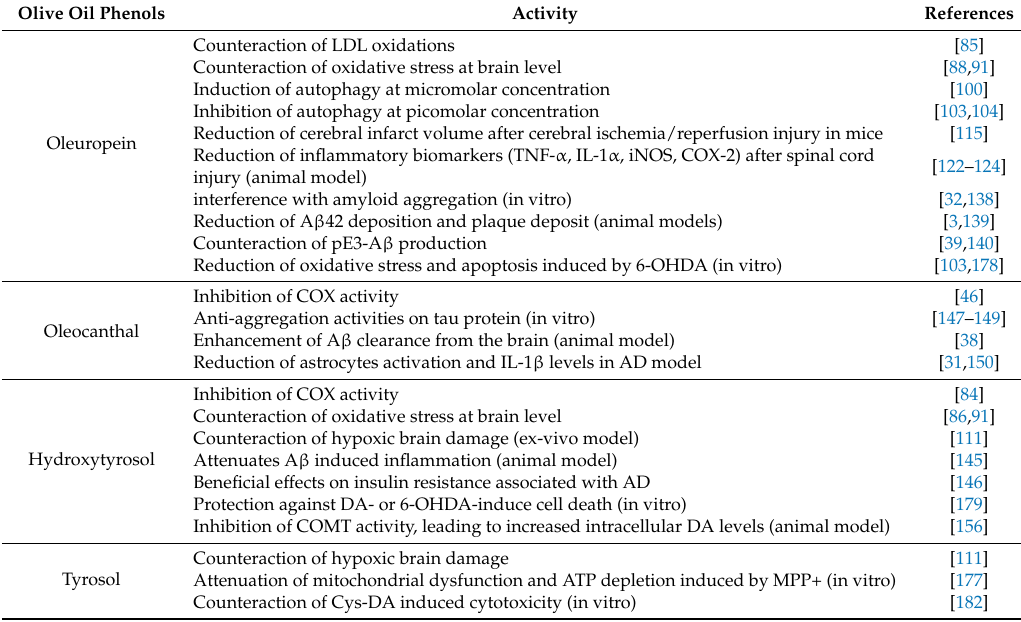
Table 1. Studies showing a protective activity of olive oil phenols against neurological